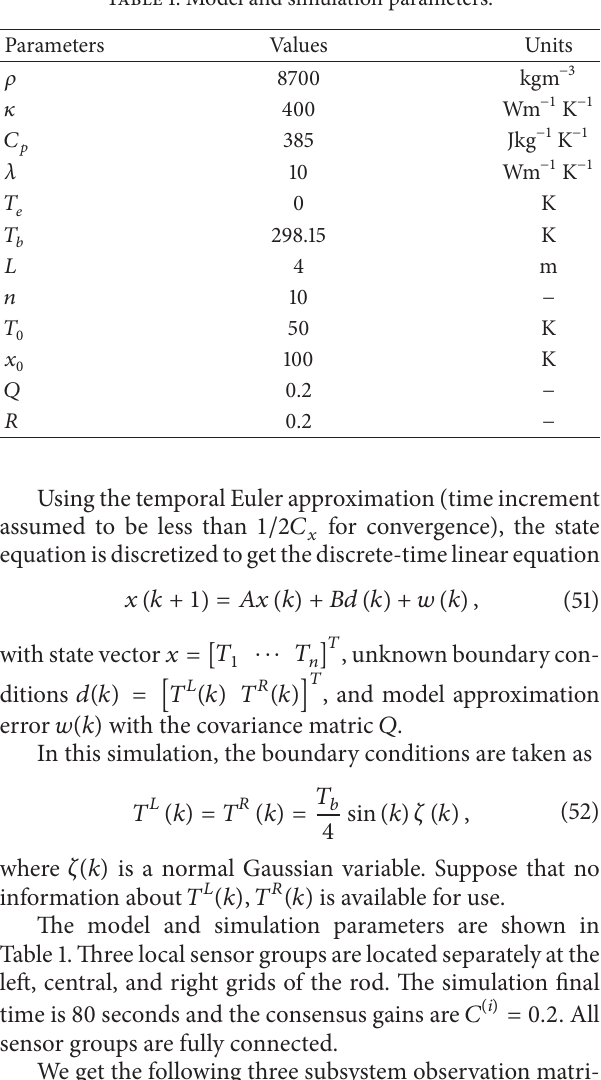
Table 1: Model and simulation